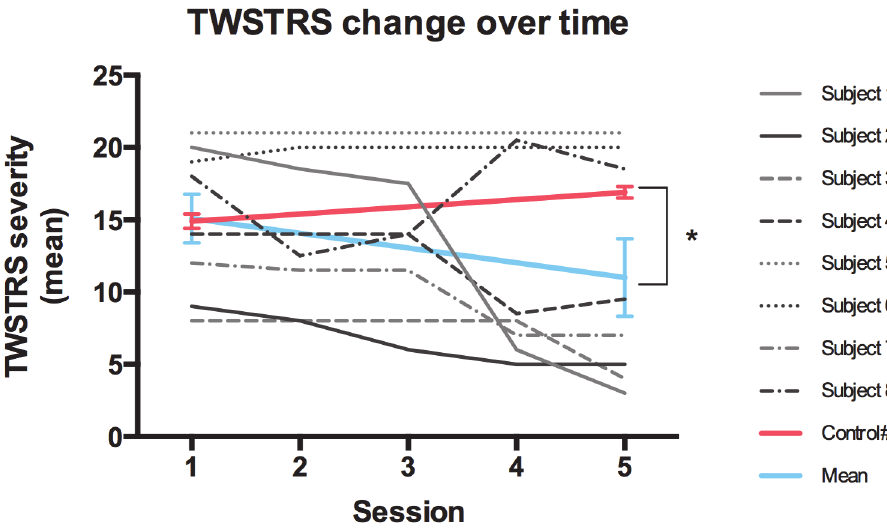
Fig 4. Change in TWSTRS severity score as a function of time shown from Session 1 to Session 5. Individual subject data shown as well as study group mean data shown in blue line. Red line represents historical control data from Comella et al., 2011 [14] showing similar severity scores at Week 8 post- botulinum toxin injection (study Session 1). * p =